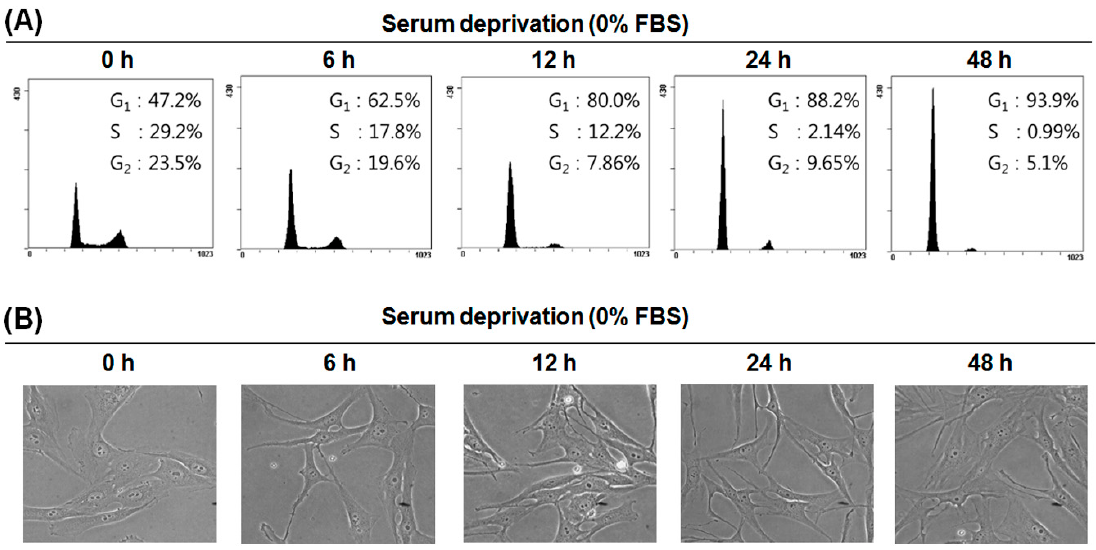
Figure 2. Typical histograms of the DNA content and cell morphology of MG-63 cells cultured under serum-free conditions. Cells were grown in serum-free medium for the indicated time periods. ( A ) DNA content was analyzed by flow cytometry; ( B ) Cell morphological images were taken by phase-contrast microscope (400×) at each time point.